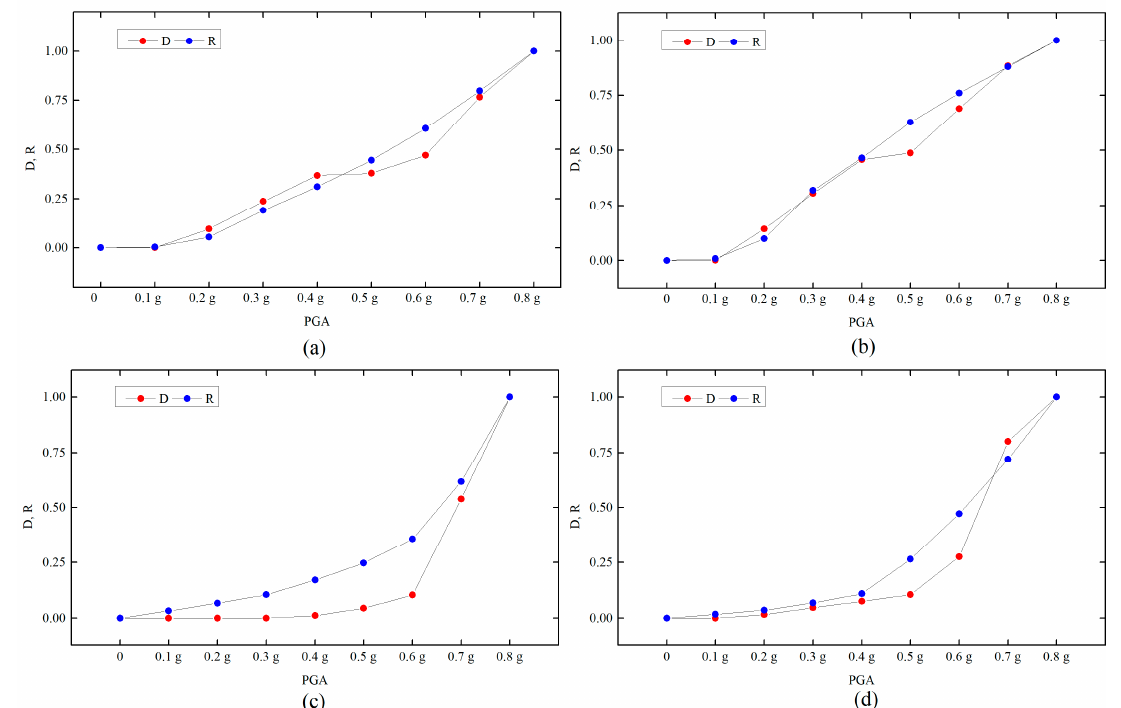
Figure 6. Correlation of R and D under various earthquake waves. ( a ) Correlation of R and D under wave 1; ( b ) Correlation of R and D under wave 2; ( c ) Correlation of R and D under wave 3; ( d ) Correlation of R and D under wave 4.